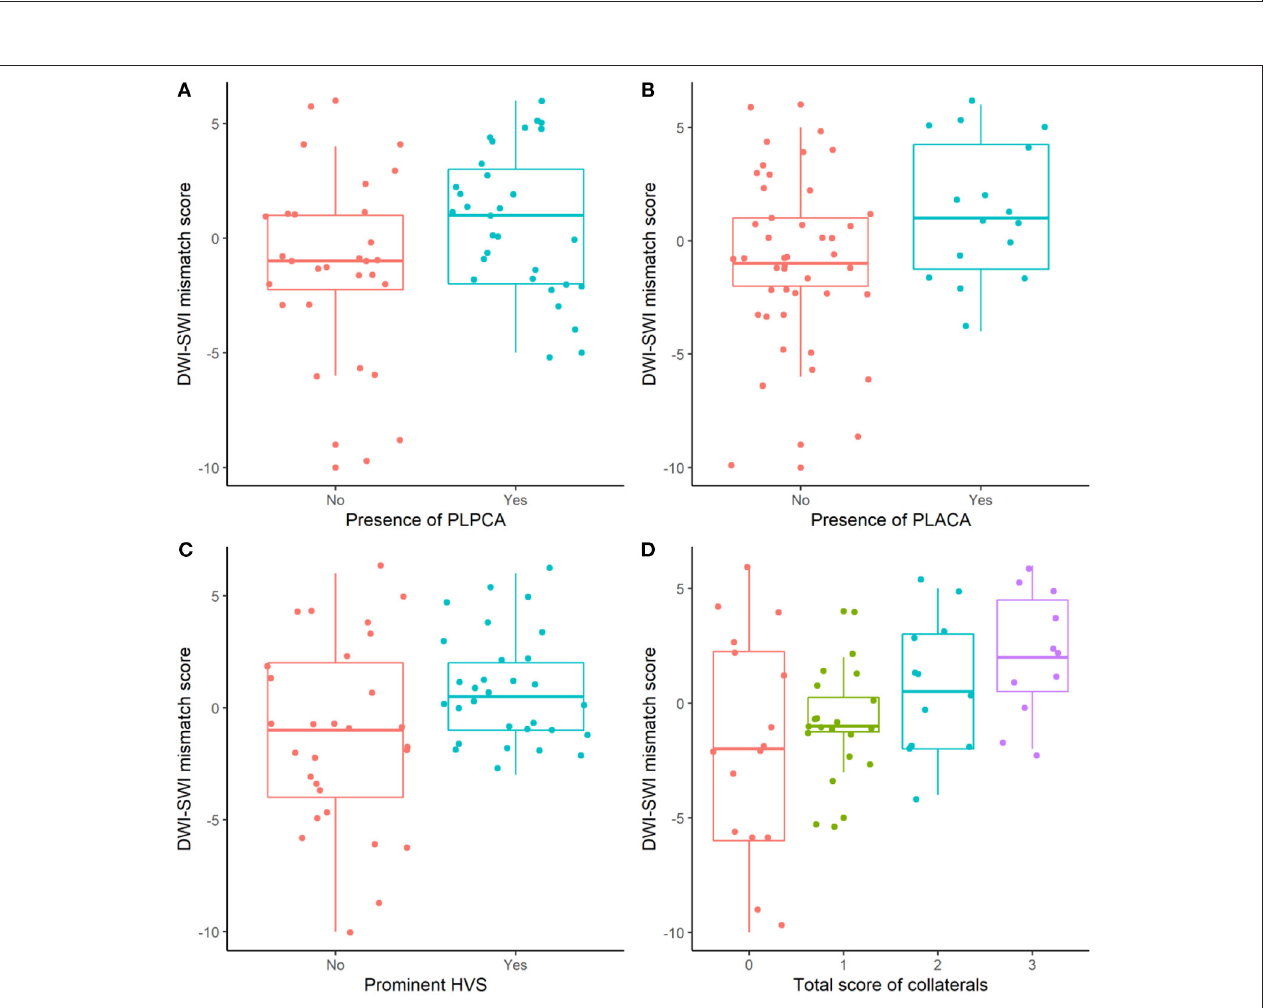
FIGURE 4 | DWI-SWI mismatch and collateral circulation: significantly differing DWI-SWI mismatch in absence vs. presence of PLPCA, PLACA, or HVS prominence, and in collective collateral scoring (all, p < 0.05).